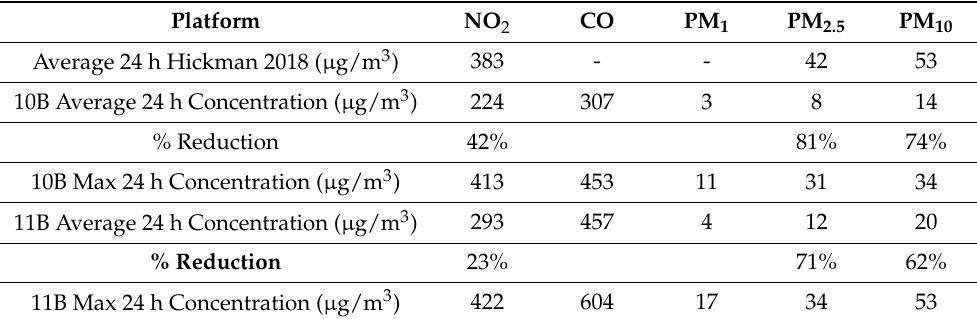
Table 2. Platform 10B and 11B average and maximal 24 h pollutant concentrations for the 68 day monitoring period (1 February–8 April 2020) In comparison to Hickman et al., 2018. All pollutant concentrations measured in µ g/m 3